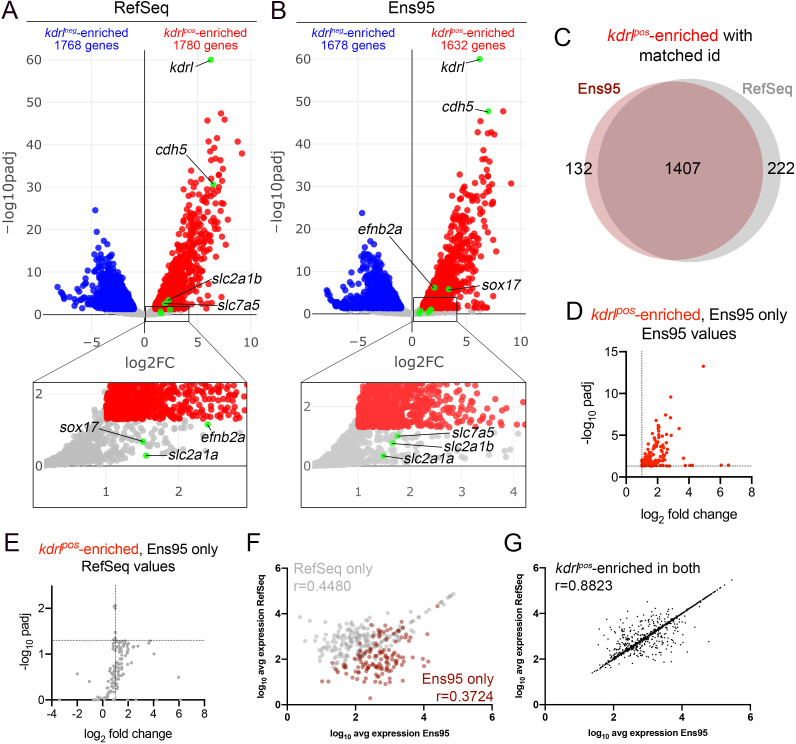
Comparison of Ensembl and RefSeq zebrafish transcriptome annotations for bulk RNA-seq analysis.(A, B) Volcano plots showing differentially expressed genes from Tg(kdrl:HRAS-mCherry)s896-positive and negative (kdrlpos and kdrlneg) cells identified using RNA-seq reads quantified with (A) RefSeq or (B) Ensembl, version 95 (Ens95) transcript annotations. Genes with significant enrichment (padj <0.05) are shown as red or blue (log2 fold change >1 or <-1, respectively) across replicate samples (n = 3). Grey dots are genes that fall below statistical cutoffs. Green dots indicate selected genes previously found to be enriched in endothelial cells in zebrafish or other models. (C) Venn diagram illustrating the intersection of genes with a common NCBI ID in Ens95 and RefSeq found significantly enriched in kdrlpos cells using either annotation. (D, E) Plots of commonly annotated genes identified as kdrlpos-enriched only by Ens95 with indicated values from (D) Ens95 or (E) RefSeq. (F, G) Correlation of expression levels from indicated annotation for kdrlpos-enriched genes identified (F) selectively as such by Ens95 (maroon) or RefSeq (grey) only, or (G) both annotations. Data are not normally distributed, Spearman correlation, r values are indicated.Figure 1—source data 1.DESeq2 output for kdrlpos and kdrlneg RNA-seq quantified with RefSeq (GCF_000002035.6_GRCz11; worksheet 1) or Ensembl, v95 (worksheet 2).Gene expression levels were quantified using RSEM. Median ratio normalized expression values are shown for each replicate, along with adjusted p-value, and log2 fold change. Data used to generate plots in Figure 1A,B, and incorporated into source data tables indicated below.Figure 1—source data 2.Intersection of kdrlpos-enriched genes from RefSeq and Ens95 commonly annotated by NCBI ID.Gene symbol, along with matching Ensembl gene ID and NCBI ID, as well as differential annotation (i.e., identified as differentially expressed only in RefSeq, Ens95, or both) are indicated. Expression data are derived from Figure 1—source data 1. Data used to generate plots in Figure 1C–G.